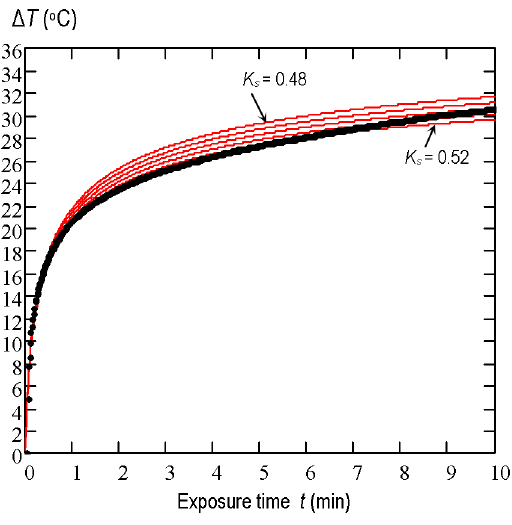
Figure 8. The temperature-time rise induced in the two-layer system of media. : 15 mm water/25 mm beef liver by the pulsed focused nonlinear beam with the average acoustic power of 2.1 W. The measurement data (points) and numerical simulation results (solid lines) at the point of maximum heating ( z =20 mm) for the assumed thermal conductivity of the beef liver varied between 0.48 W/(m ? u C) and 0.52 W/(m ? u C) with an increment of 0.01 W/(m ? u C).